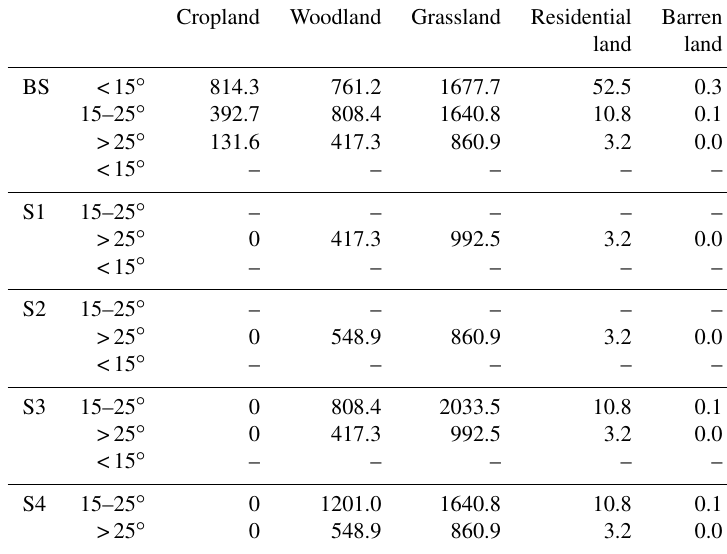
Table 5. Slope characteristics of each land use type at baseline and under different slope land conversion scenarios (unit: km 2 ).